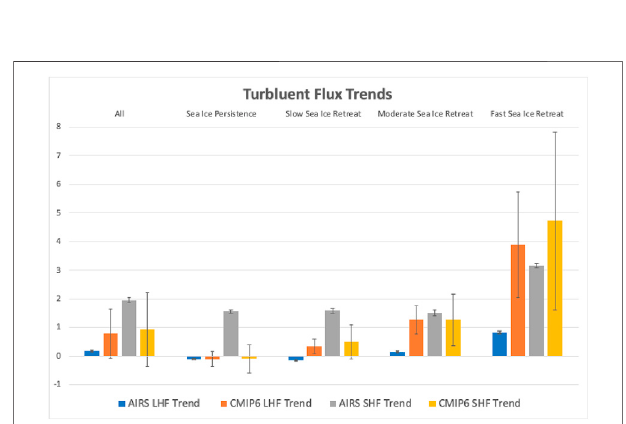
FIGURE 4 | Bar plot summarizing the Arctic winter (ONDJ) surface turbulent fl ux trends (Wm − 2 per decade) by sea ice loss regime. Average trends for both AIRS-derived and CMIP6 ensemble-means are shown in the bars. The standard error of the AIRS-derived turbulent fl ux trends are shown in the error bars and the error bars for the CMIP6 ensemble-mean turbulent fl ux trends represent the inter-model spread.